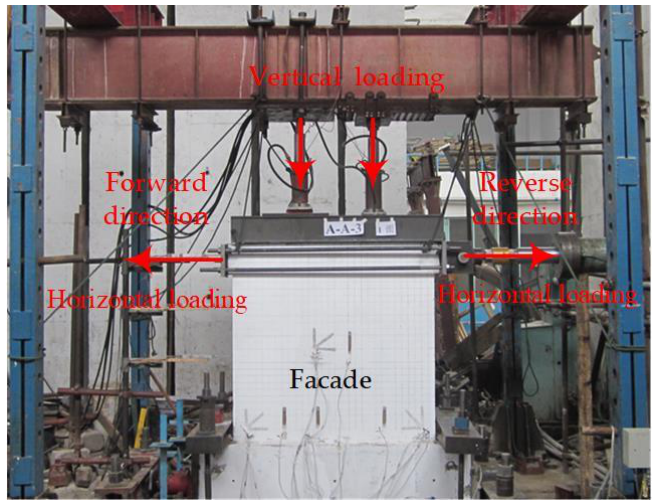
Figure 5. Experimental loading device.